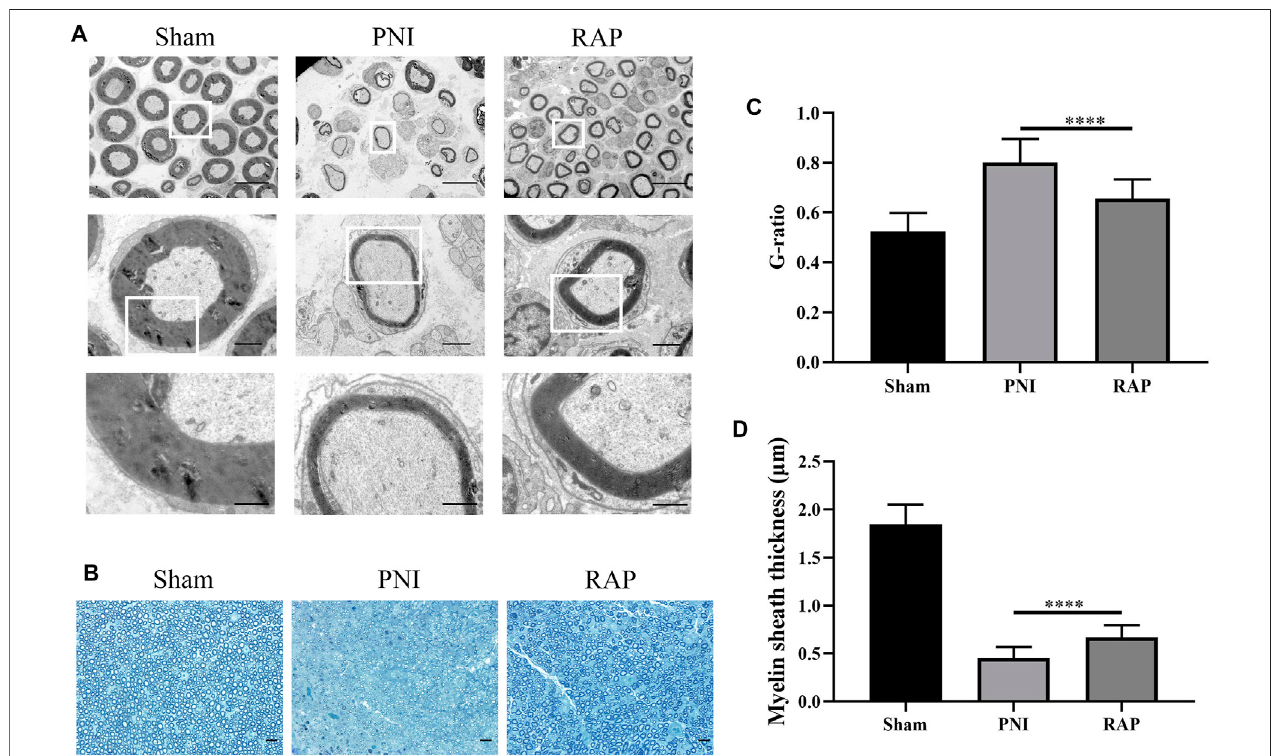
FIGURE 6 | RAP promoted remyelination after PNI (A) Representative TEM images of sciatic nerve transverse sections in each group 28 days after PNI (1000×, 4,000×, 10000× ampli fi cation, scale bars = 10 μ m, 2 μ m, or 1 μ m); (B) Representative images of TB staining of sciatic nerve transverse sections in each group 28 days afterPNI(400×ampli fi cation,scalebar=20 μ m); (C) StatisticalanalysisofG-ratio; (D) Statisticalanalysisofmyelinsheaththickness.Dataarepresentedasmeans±SD, **** p <